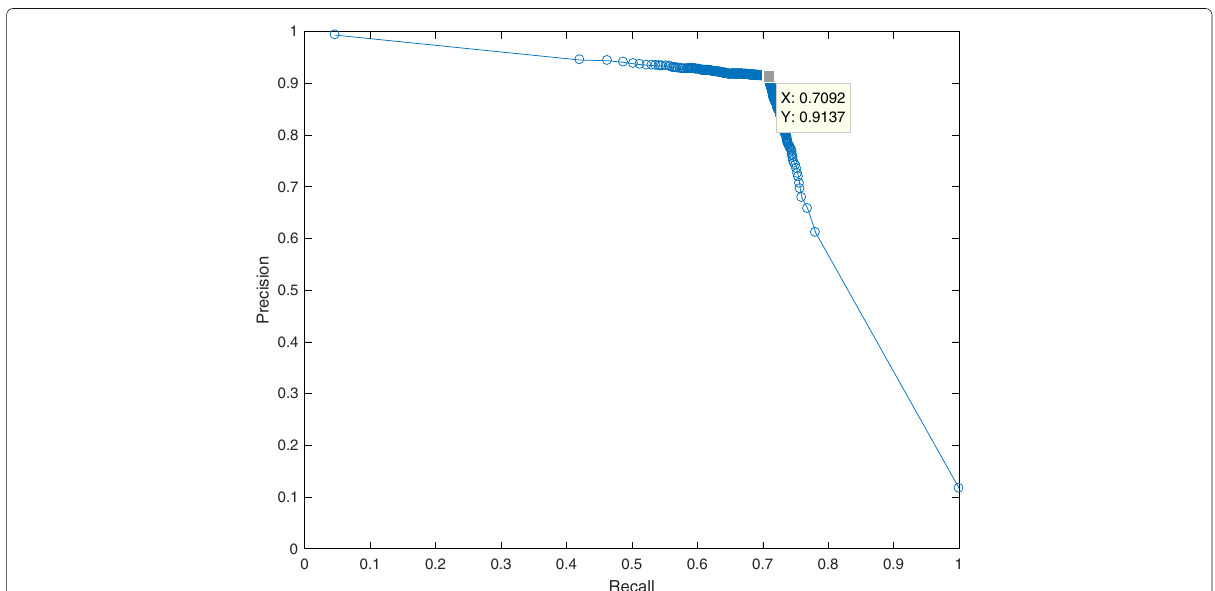
Fig. 7 Precision-Recall Curve of P7. “Detection” module produces similar results when t varies in a relatively large interval around 0.5, the best result is shown by a gray square